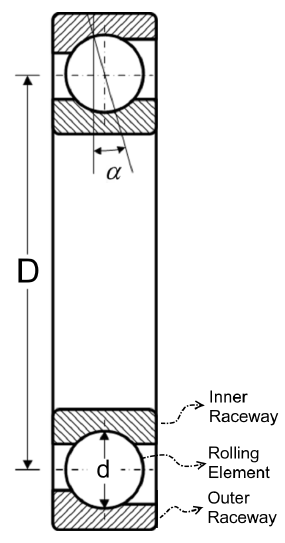
Figure 1. Geometric parameters of a bearing-side